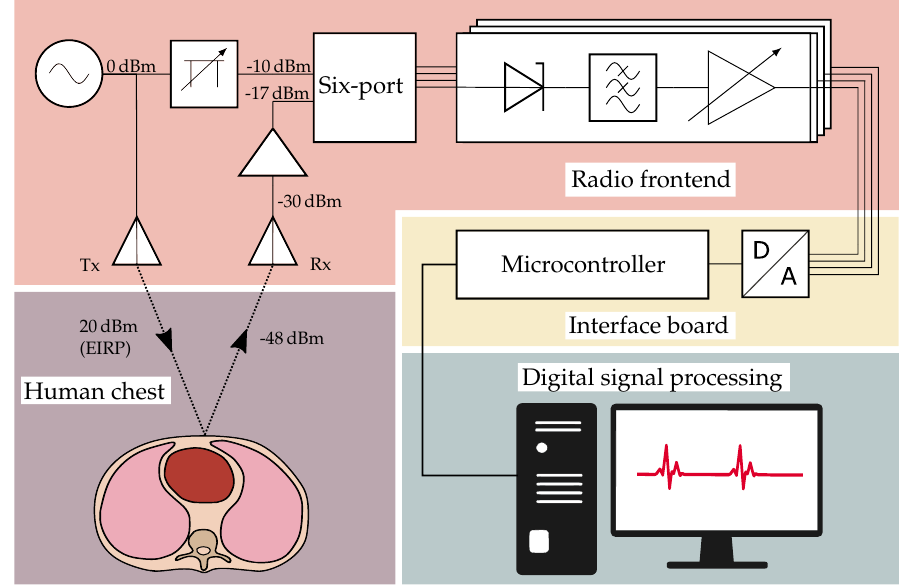
Figure 3. Block diagram of the vital parameter radar sensing